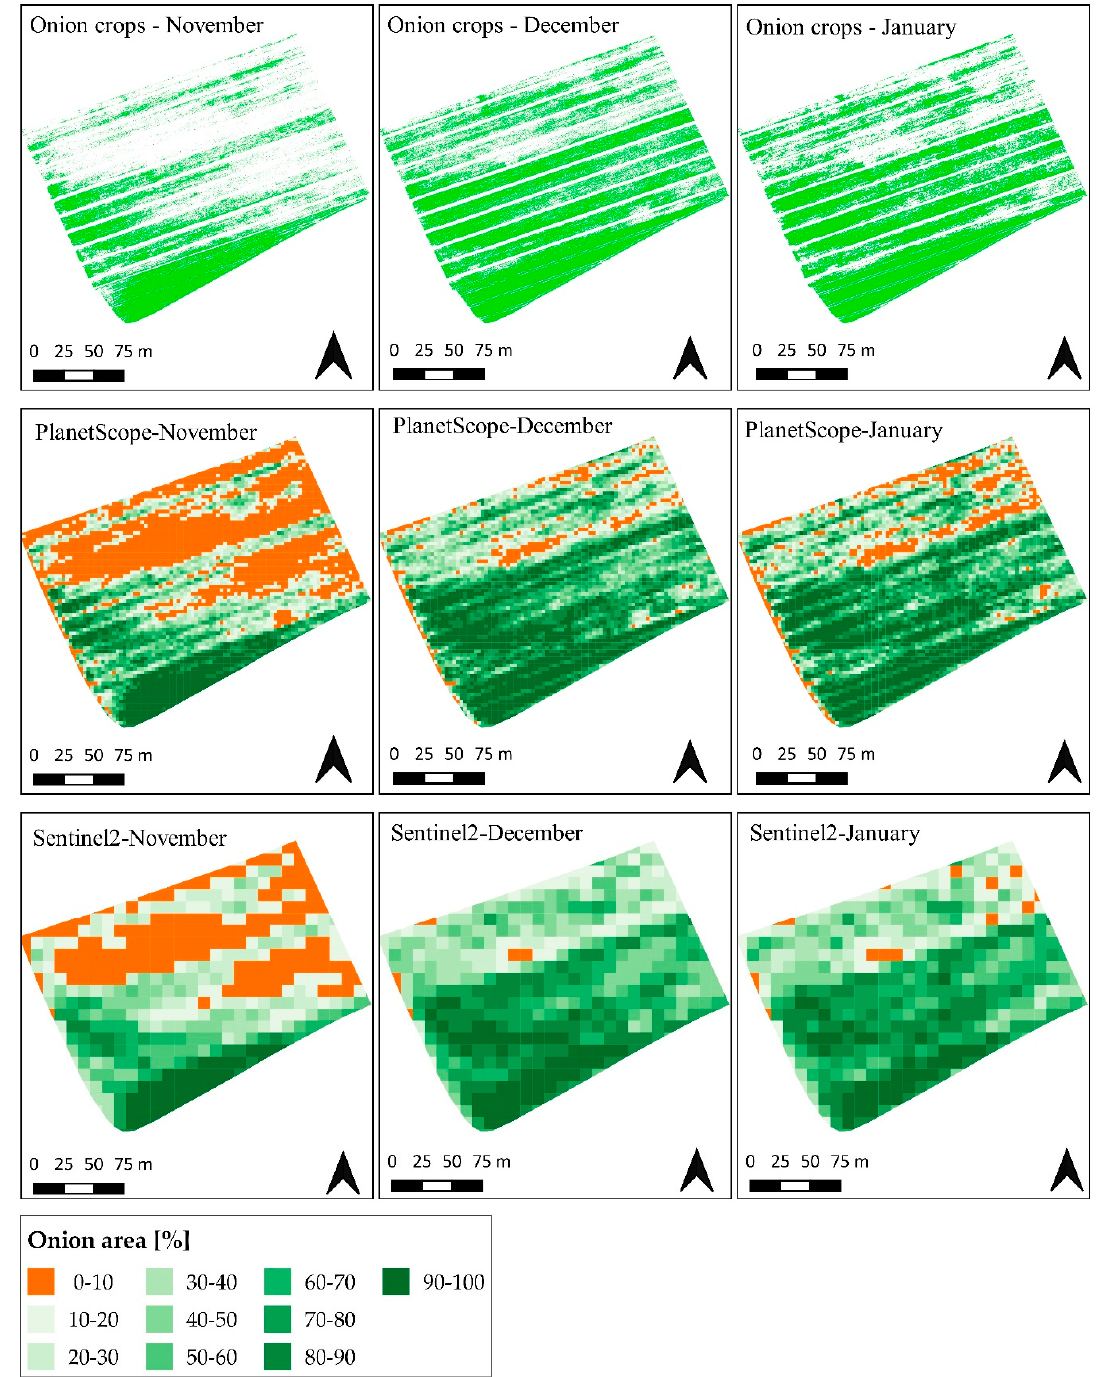
Figure 9. Maps showing onion crop area, derived from the UAV imagery (top), and the percentage of area covered by onion crop within PlanetScope’s (center) and Sentinel-2’s (bottom) pixels at their native resolutions (3 m for PlanetScope, and 10 m for Sentinel-2). Pixels in orange contained a percentage of the pixel area occupied by vegetation between 0 and 10% and could be assimilated to pure pixels of bare soil. On the other hand, pixels in dark green could be assimilated, with a percentage of the pixel area occupied by vegetation between 90 and 100%, to pure pixels of vegetation. The remaining pixels, colored with di ff erent shades of green, were mixed